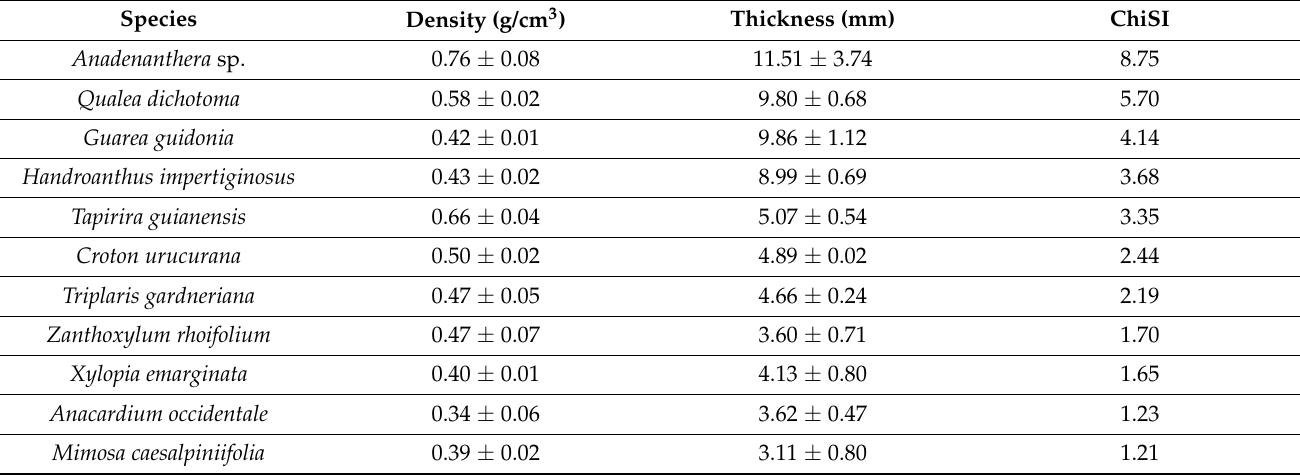
Figure 2. ( A ) The use of the Croton urucurana tree as a source of exudate by the black-tufted marmoset ( Callithrix penicillata ). Round (white arrow) and elongated (black arrow) shaped holes in the trunk. ( B ) Several holes were distributed throughout the trunk and branches. ( C ) C. urucurana exudation. Table 2. Bark density, thickness and ChiSI (Chiseling Suitability Index) of exudating trees, exploited by black-tufted marmosets ( Callithrix penicillata ), in three urban forest fragments of the municipal- ity of Goi â nia, GO, Brazil. Density and thickness are expressed in mean ( ± standard deviation). The ChiSI is a product between the density × thickness, and there is no derivative metric unit to express